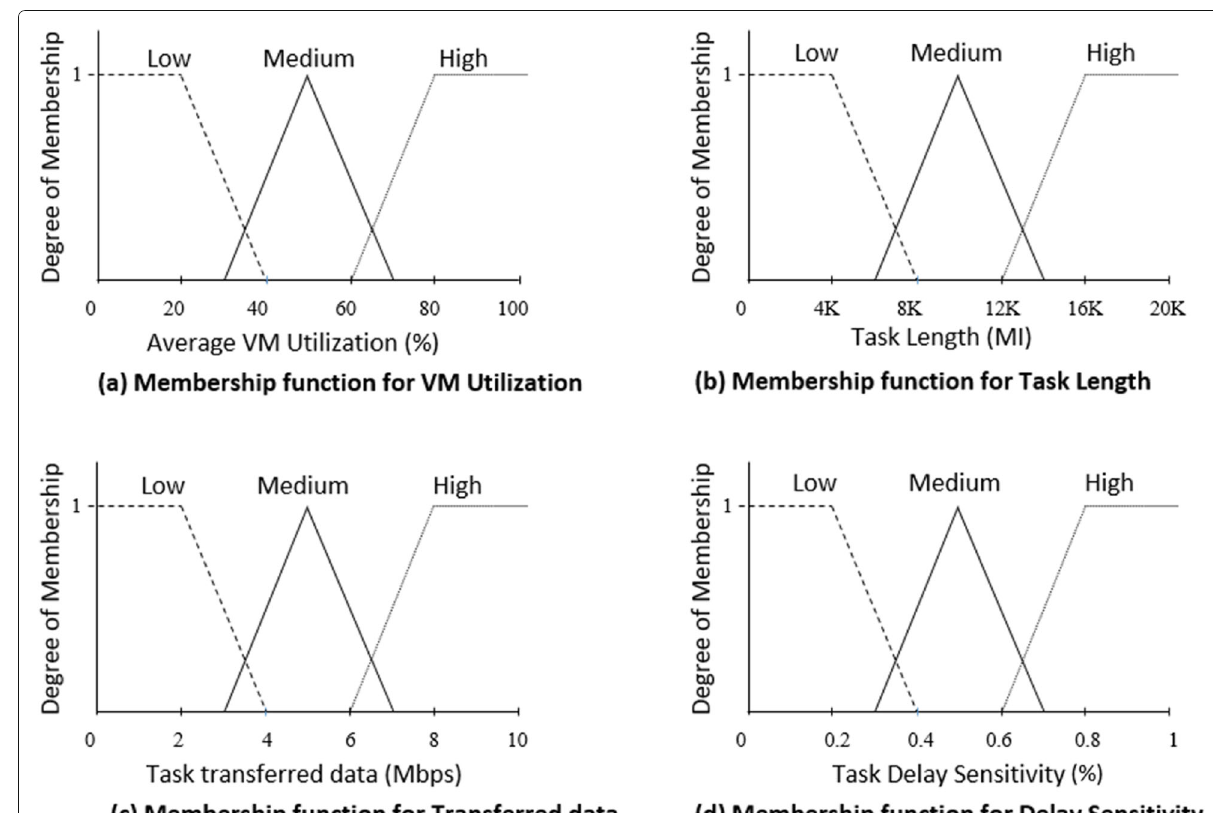
Fig. 4 The four membership functions a range of ways to produce the output membership function in the fuzzy logic system and these examples of the often-used method (e.g., maximum, mean of maximum and centroid). This work adopts the maximum approach because our membership function has one maximum at a time. Figure 5 represents the output membership function of the fuzzy logic system. For example, if the output fuzzification process is 38, then μ LocalEdge is 0.1 and μ CollaborativeEdge is 0.4, the defuzzification process will take the maximum, and the task will be offloaded to the other collaborative edge